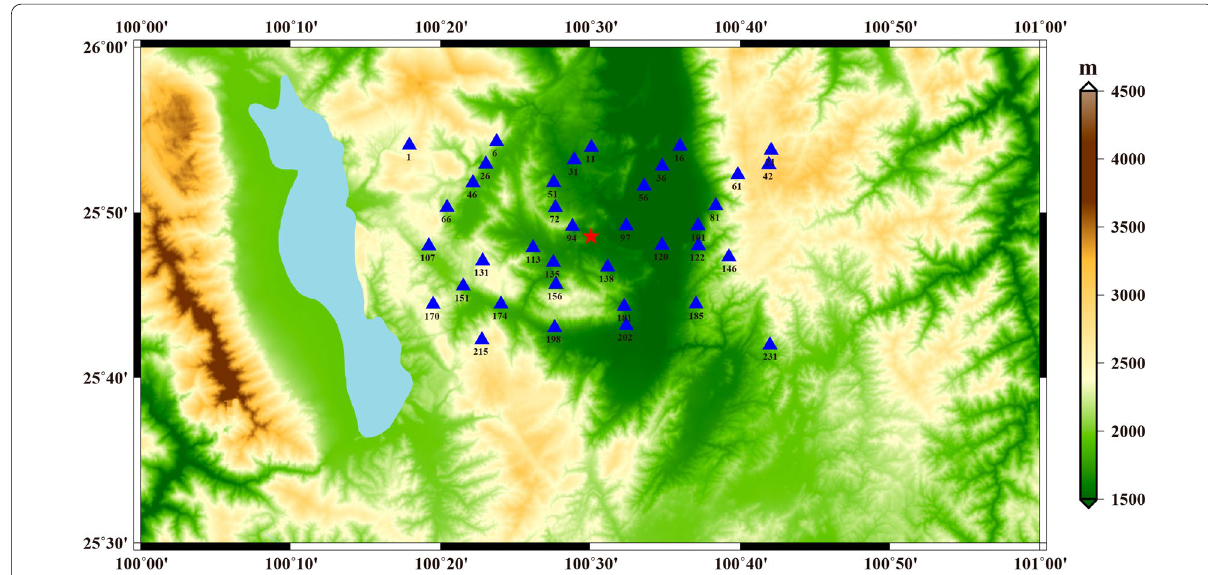
Fig. 1 Locations of the Binchuan Fixed Airgun Signal Transmission Station and the stations. Red star shows the location of airgun signal transmission station, blue triangles denote the location of the 37 stations used in this study